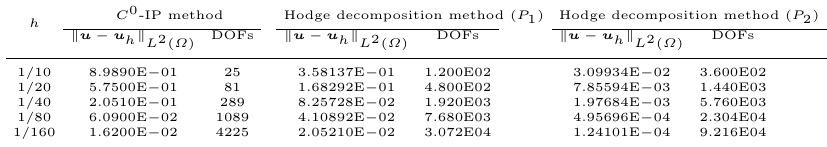
Table 2. DOFs required for achieved error of (cid:107) u − u h (cid:107) L 2 ( Ω ) for Experiment 1. 0-IP h C